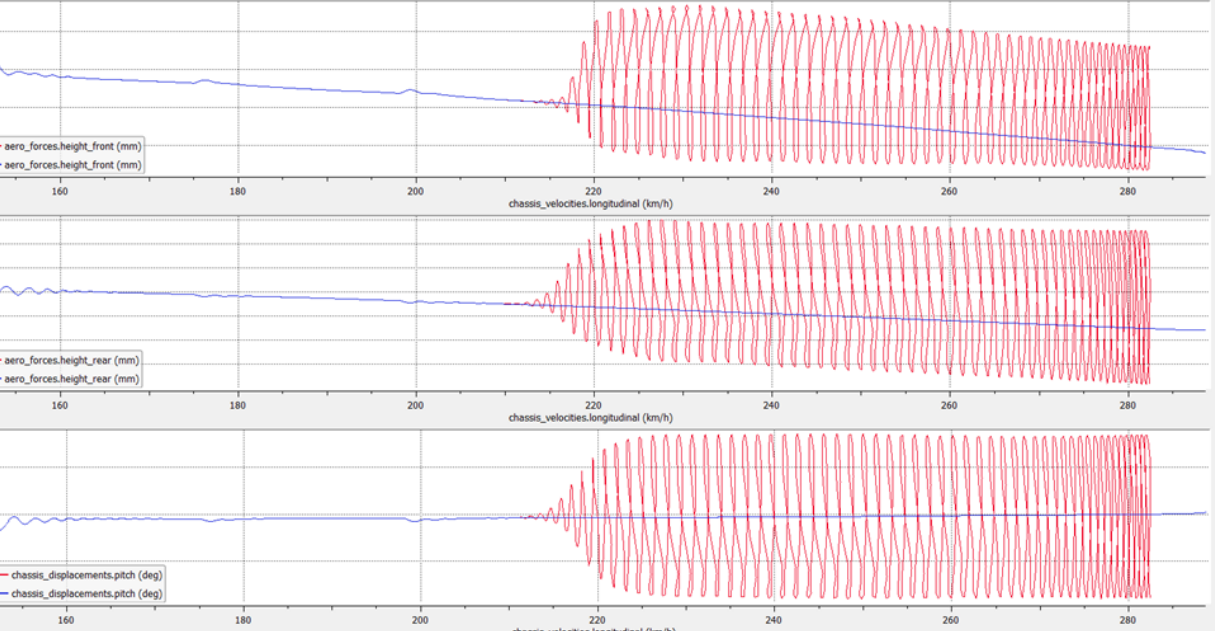
13 of 26 Figure 15. Decay effect on ride heights as a function of vehicle speed: ( a ) efficiency vs. aero balance;